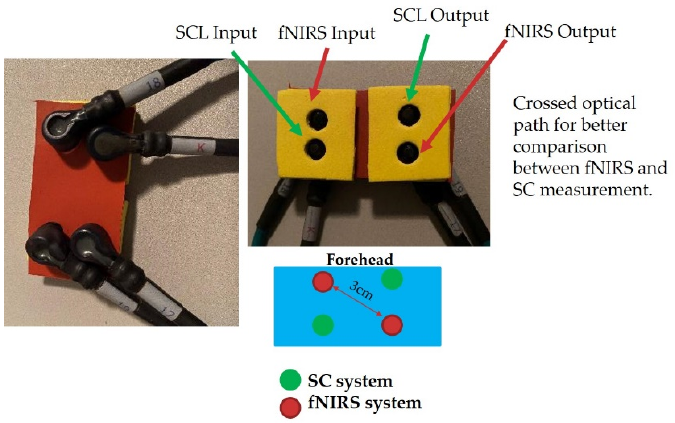
Figure 12. Modified SCL probe for the attention tests, where the excitation and receiving fibers for the fNIRS system are interleaved with the fibers for the SCISCCO system.